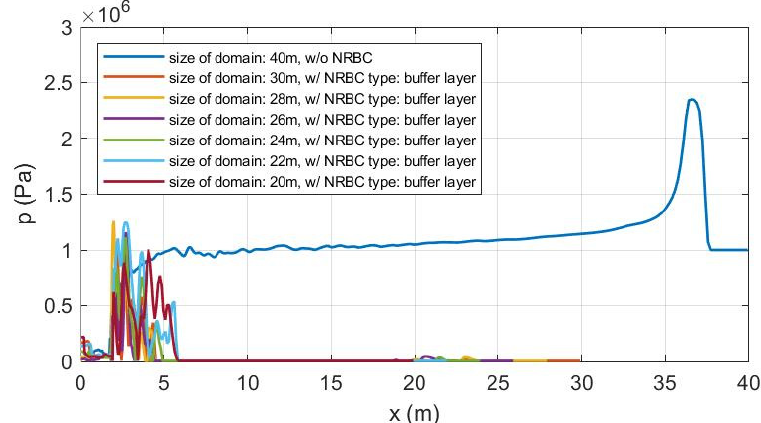
Figure 23. Buffer layer type NRBC and its performance.